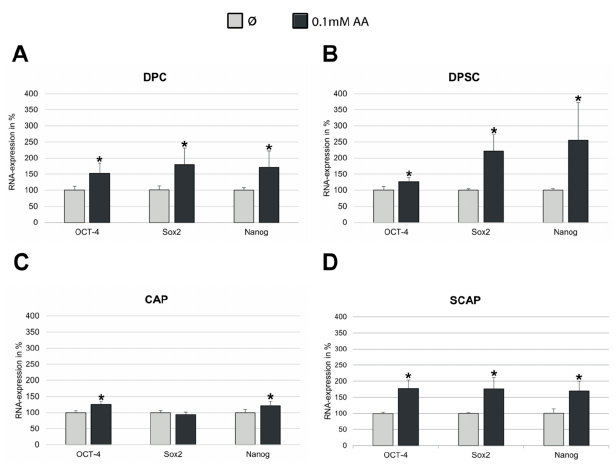
Figure 3. Expression of stem cell markers OCT-4, Sox2, and Nanog in ( A ) DPC, ( B ) CAP, ( C ) DPSC, and ( D ) SCAP treated with 0.1 mM AA. Means ± SD of three independent experiments; * p < 0.05 indicates statistical significance vs. Ø (0 mM AA).